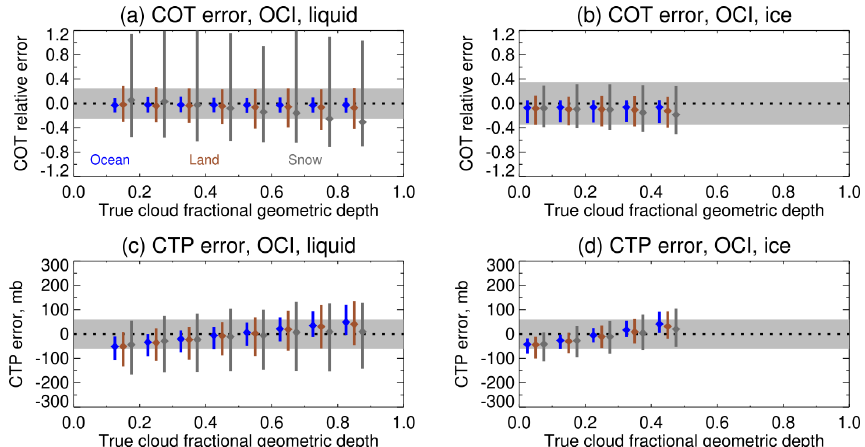
Figure 13. Retrieval error as a function of cloud FGD, for OCI, for the case where cloud phase is known beforehand. Points indicate the median retrieval error and vertical lines the central 1 σ of results within each bin. Blue, brown, and grey indicate ocean-like, land-like, and snow-like simulations, slightly offset from one another horizontally for clarity. Panels (a) and (b) show COT and (c) , (d) CTP. Panels (a) and (c) show results for liquid-phase simulations, and (b) and (d) for ice-phase simulations. Grey shading indicates the PACE mission goal uncertainties: 25% for liquid-phase COT, 35% for ice-phase COT, and 60mb for CTP (the latter for COT ≥ 3 only). The dotted line indicates an error of zero.